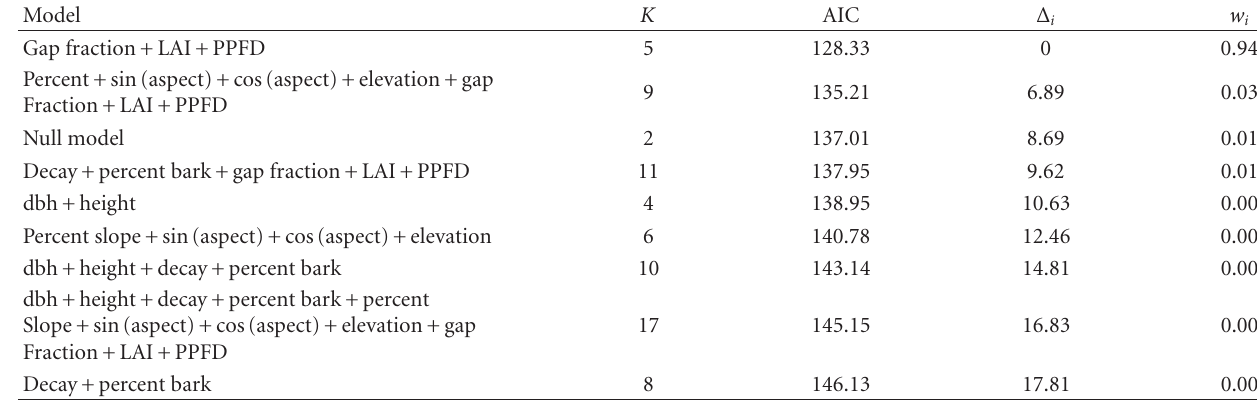
Table 4: Rankings of models used to compare female Myotis septentrionalis day roosts used during lactation and non-lactation periods on the Fort Knox military reservation in Hardin, Bullitt, and Meade counties, Kentucky, USA, 2011. Model parameters are given as well as number of parameters ( K ), Akaike’s information criteria (AIC) value, di ff erence in AIC value between top model and i th model ( Δ i ), and model support ( w i ).